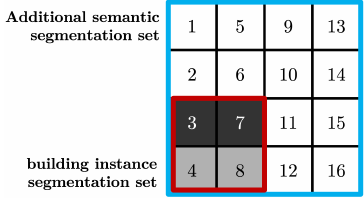
Figure 2. Splitting of training (light gray) and test tiles (dark gray) for the building instance segmentation task. Further areas with semantic segmentation annotations (white) are provided.